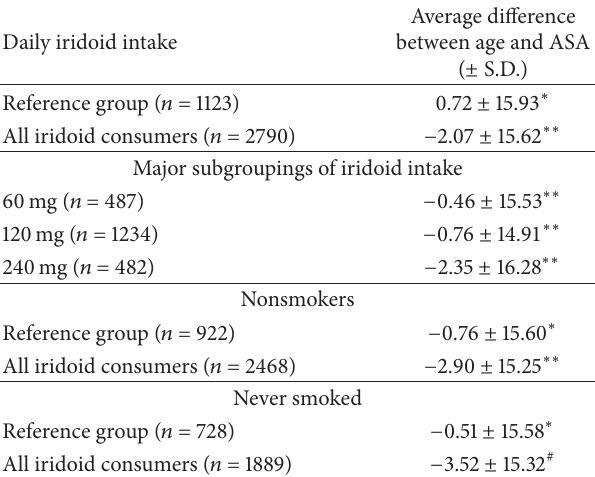
Table 1: Average differences between participant age and AGE associated age (ASA) among iridoid consumers and nonconsumers in a cross-sectional population study with 3,913 participants.